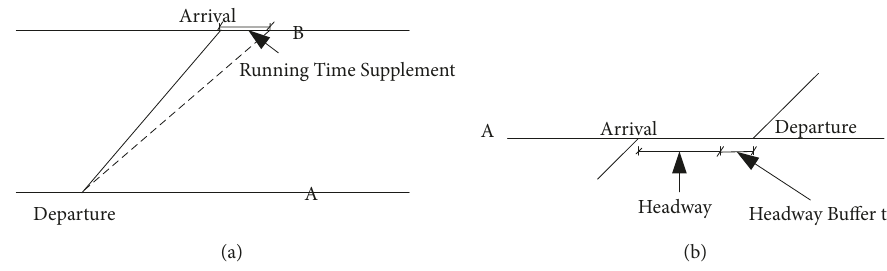
Figure 1: Illustration of headway buffers and run time